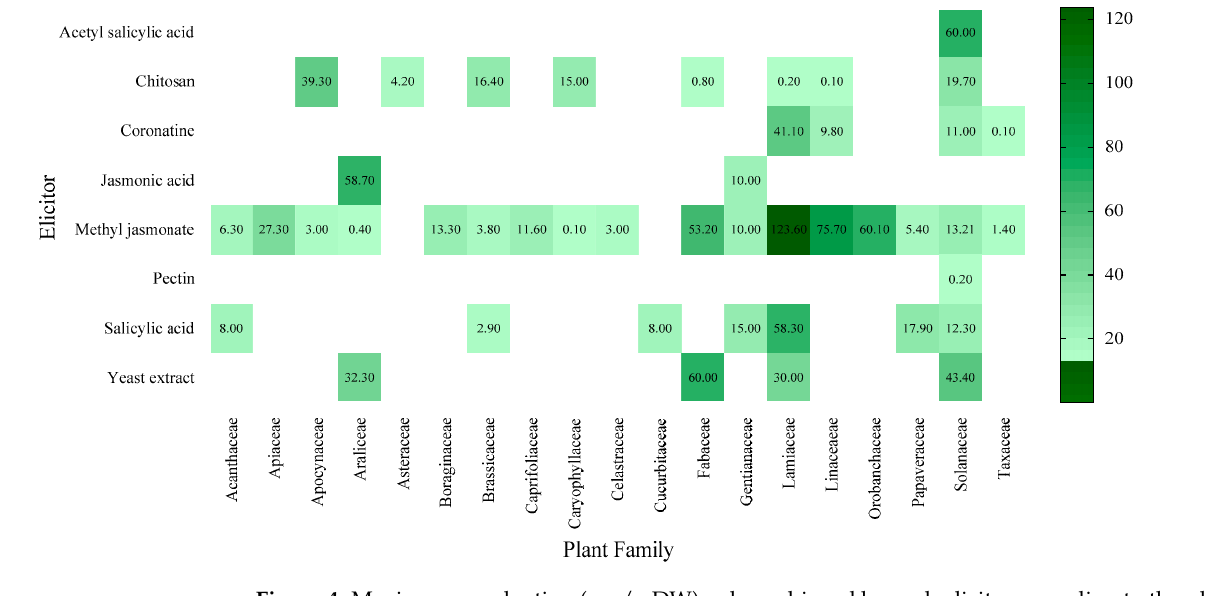
Figure 4. Maximum production (mg/g DW) value achieved by each elicitor according to the plant family, from 2010 to 11 January 2022. Table 5. Concentration range and mode value ( µ M) of each elicitor by plant family, from 2010 to 11 January